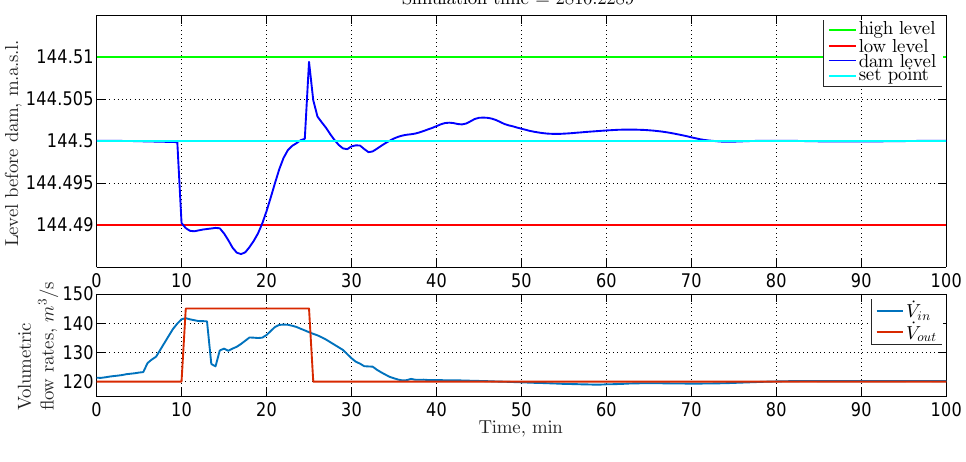
Figure 13: The results of simulation of MPC ( λ e = 2 · 10 8 , N = 24 and T s = 30).